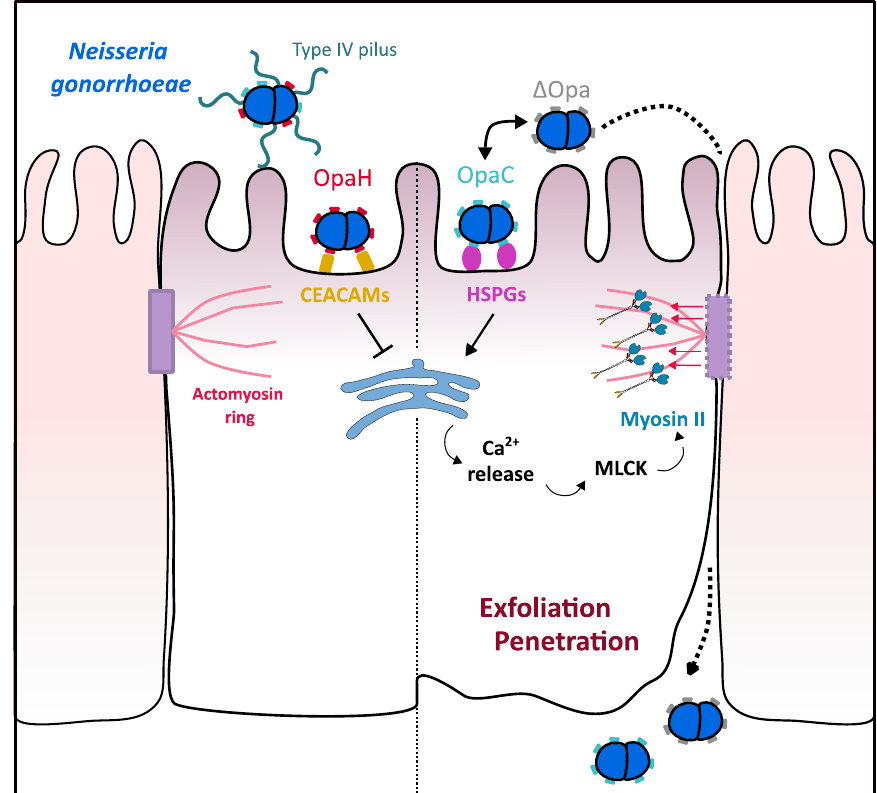
Figure 3. Role of myosin II in N. gonorrhoeae epithelial barrier crossing. (A) N. gonorrhoeae is able to cross epithelial barriers by altering epithelium permeability. Interaction of the bacterial OpaC surface proteins with HSPGs triggers Ca2+ release from cell stocks, thus leading to the activation of myosin light chain kinase (MLCK) protein. Myosin II, thus activated by MLCK, generates strength on actin filaments associated with adherent junctions, which leads to exfoliation of epithelial cells and subsequent Neisseria crossing the endocervical epithelium. Neisseria is able to balance this mechanism by controlling through “phase variation” the expression of either OpaC that triggers exfoliation or OpaH that binds CEACAMs and ensure epithelial permeability.